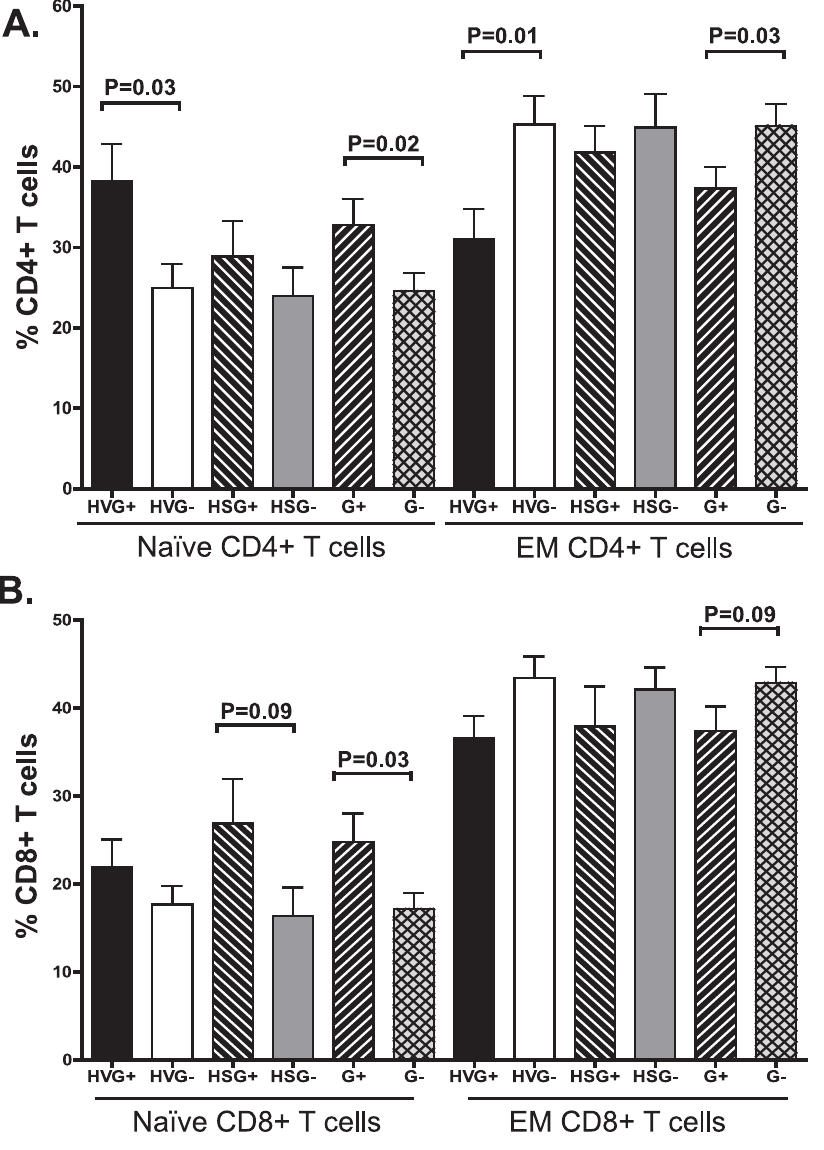
Figure 4. GBV-C is associated with altered distribution of naı¨ve T cells in treated and untreated HIV-infected subjects. The proportion of naı¨ve CD4 + (A) and CD8 + (B) T cells was higher in GBV-C viremic (G + ) subjects compared to those without GBV-C viremia (G-). Results of subjects not receiving combination antiretroviral therapy (HIV viremic; HV) or those with suppressed HIV RNA on therapy (HS) and statistical evaluations are provided. In contrast, the proportion of effector memory cells (EM) was lower in G +